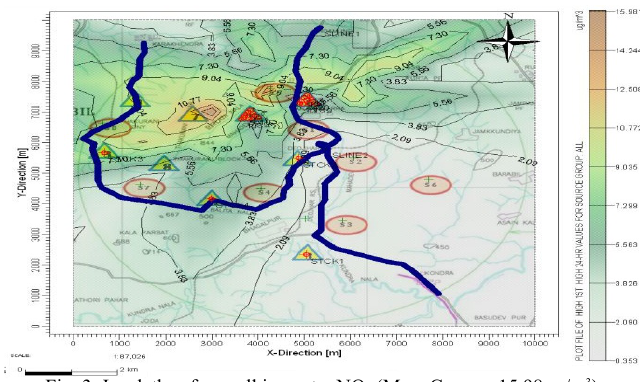
Fig. 3: Isopleths of overall impact – NO